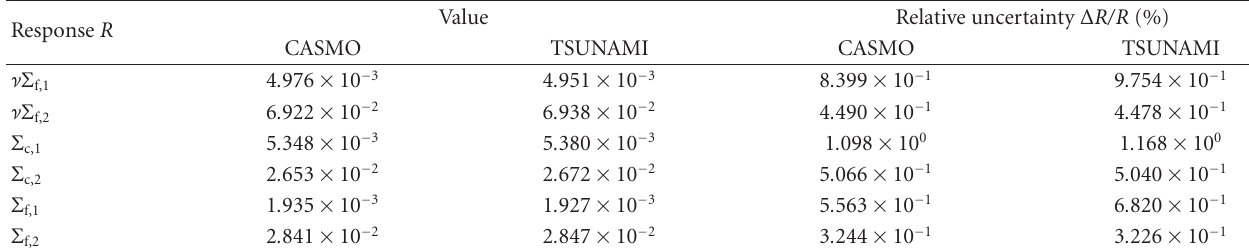
Table 4: Values and uncertainties of the responses considered in the GPT framework.